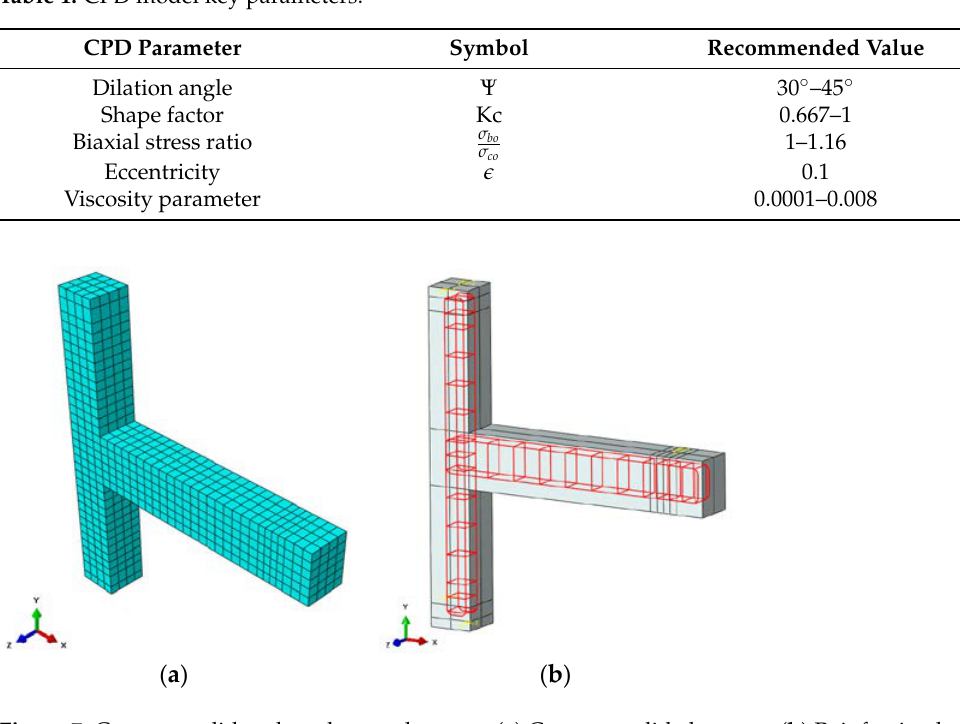
Figure 7. Concrete solid and steel truss elements. ( a ) Concrete solid elements. ( b ) Reinforcing bars truss elements.